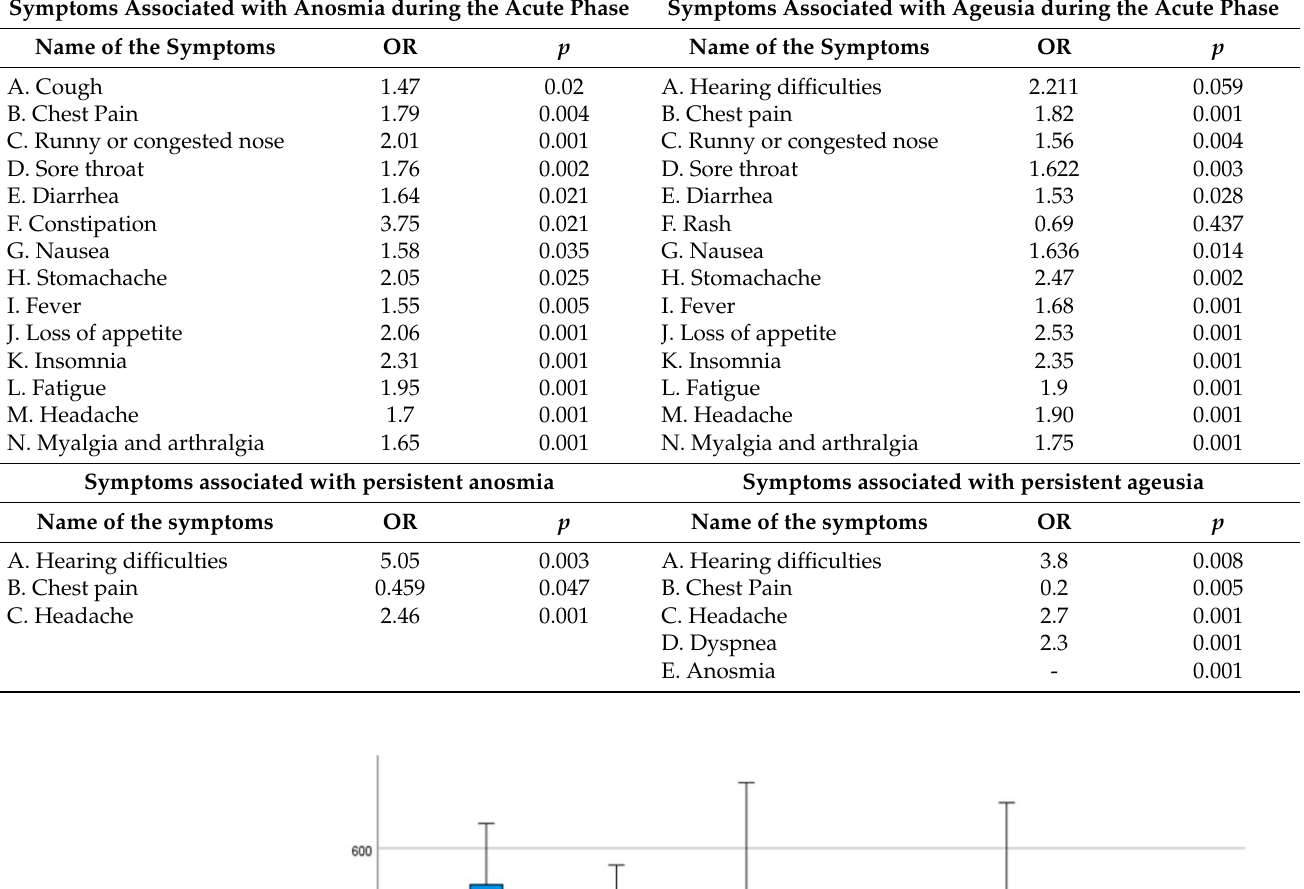
Table 5. List of the associated symptoms with anosmia and ageusia.